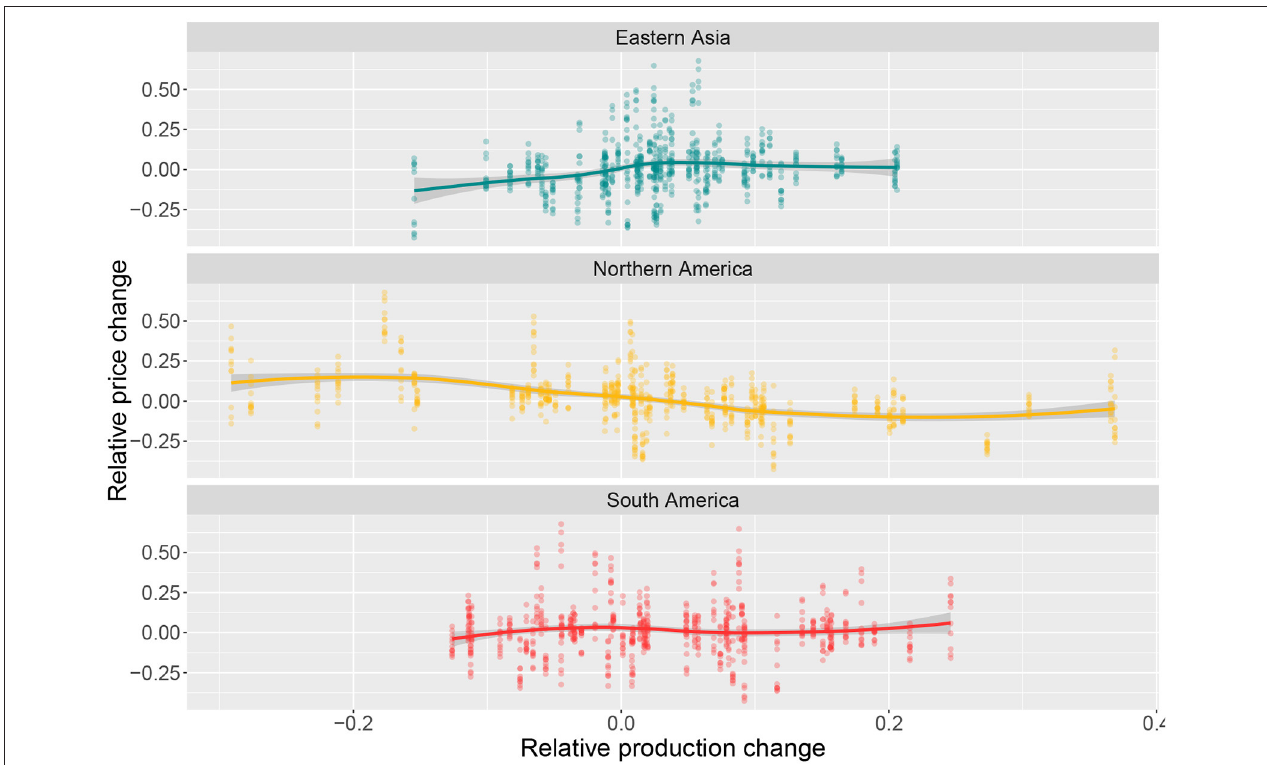
FIGURE 1 | Annual changes (%) in global price vs. Regional production (in the three leading producing regions). Each dot represents an observation, while the smooth line (fitted using loess) shows the pattern of these two